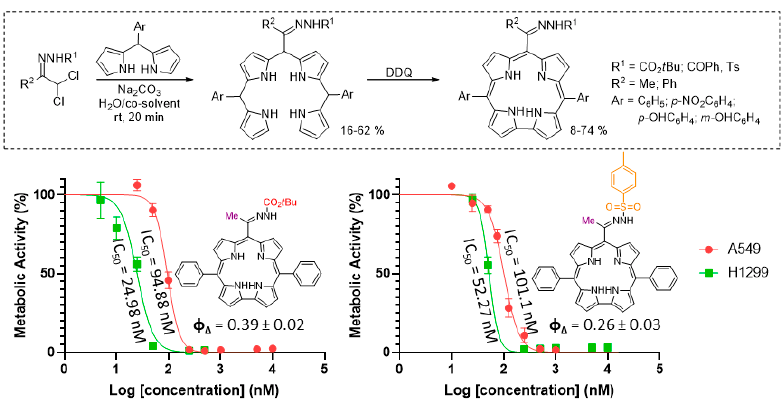
Figure 1. Synthesis of corroles and properties of most promising Figure 30. Synthesis of corroles and properties of most promising corroles.